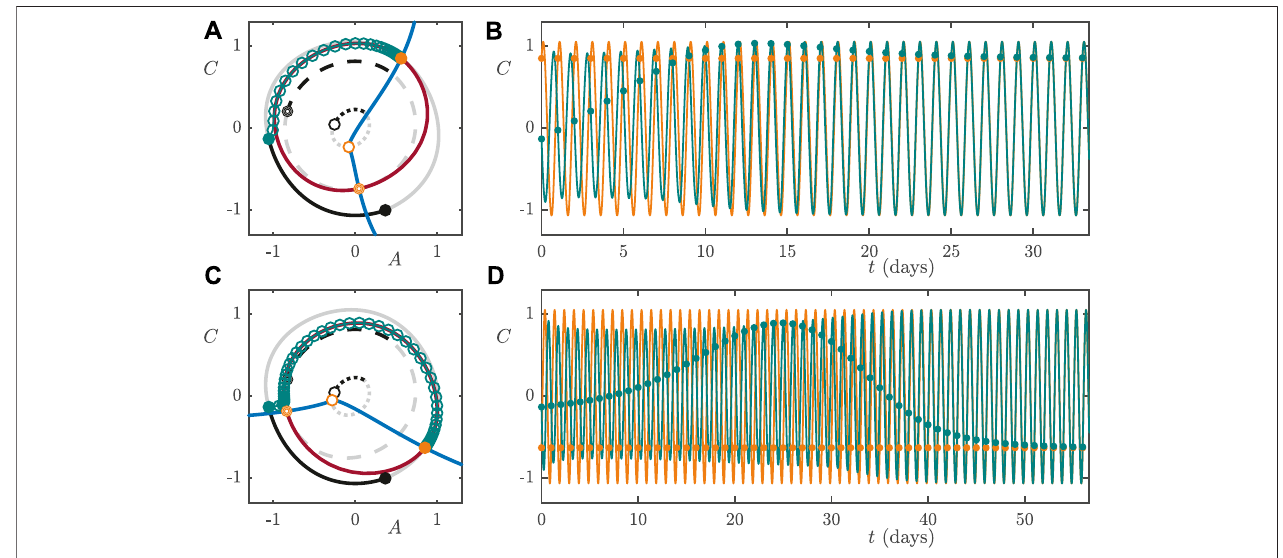
FIGURE 11 | Low lux ( I (cid:1) 50) entrainment dynamics for τ c (cid:1) 24 . 2 and N (cid:1) 17. (A) + (B) : Dynamics following transition from day shift to night shift (DS → NS). (A) : Projections of the periodic orbits, and their points of zero phase, for the day shift are shown in black (and grey). The points of zero phase corresponding to the periodic orbits for the night shift (which has a different phase of entrainment than the day shift) are shown in orange. The unstable and (strong) stable manifolds of the periodic orbits at the phases indicated by the orange markers are shown in red and blue, respectively. The worker transitions from DS → NS when f ( t ) (cid:1) 1 → f ( t ) (cid:1) 0, with their instantaneous ( A , C ) values at this time indicated by the solid teal dot (to the left of the panel). The open teal markers indicate the ( A , C ) values of the trajectory starting from this point evaluated at successive 24 h intervals. The trajectory ultimately converges to the entrained phase indicated by the solid orange marker. (B) : Time courseof C oftheentrainingtrajectory(teal)asitconvergestothestableentrainedperiodicorbitofthenightshift(orange).Solidmarkersoneachtrajectoryindicatethe C valueofthetrajectoryevaluatedatsuccessive24hintervals[correspondingtotheopentealmarkersinpanel (A) ]. (C) + (D) :Dynamicsfollowingtransitionfromnightshift to day shift (NS → DS), following the same format as panels (A, B) . See the Supplementary Material for movies of the entraining